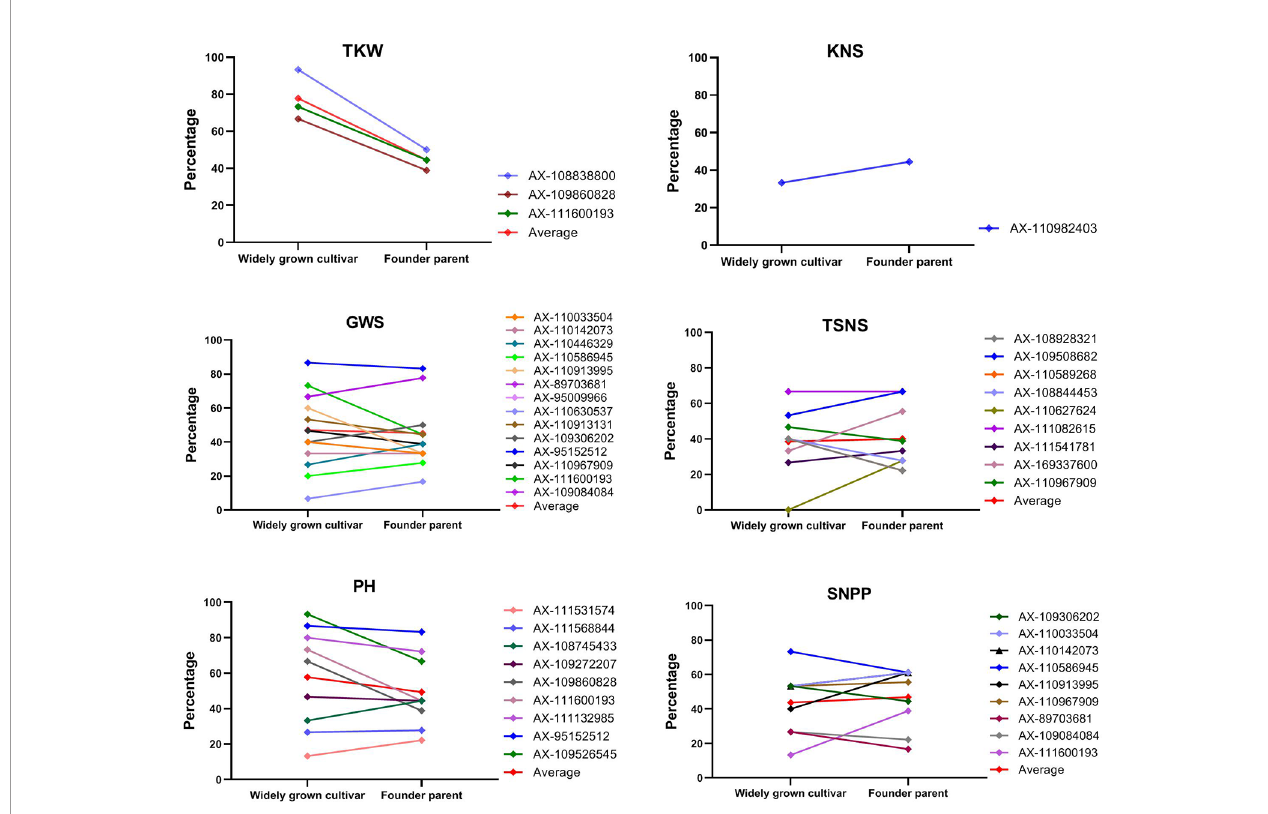
FIGURE 6 | The percentage of cultivars with superior alleles at different signi fi cant loci for six traits in widely grown cultivars and founder